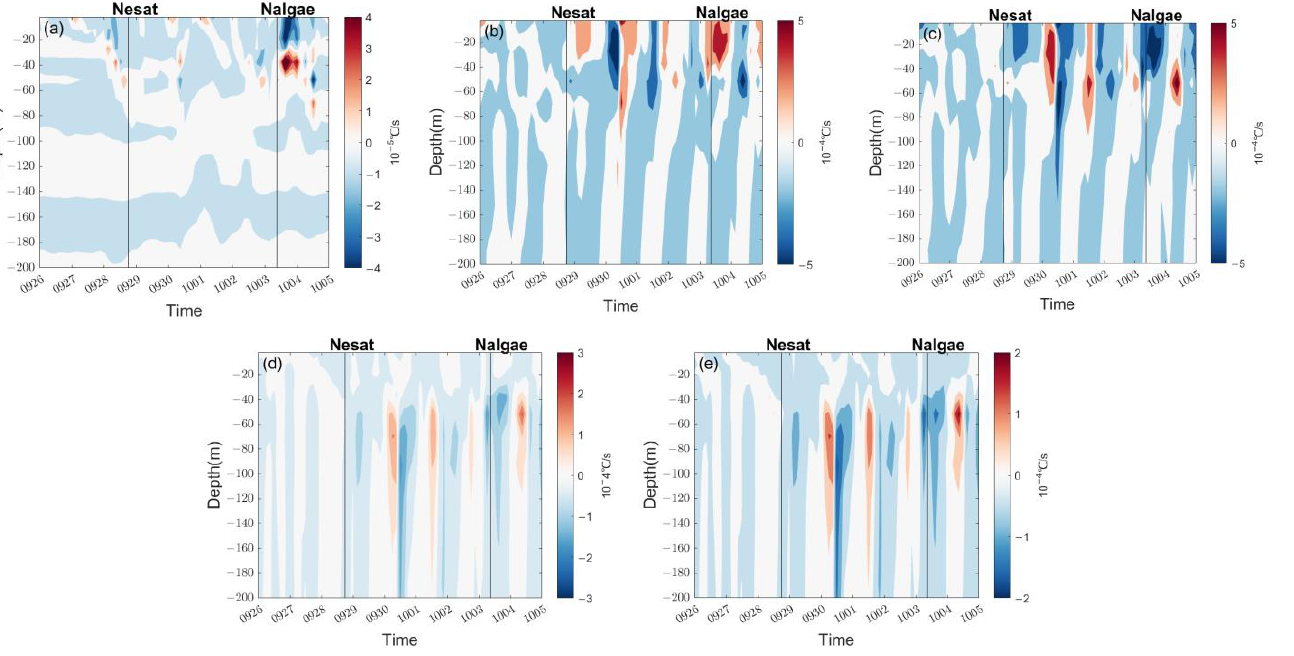
Figure 7. Ocean heat budget term at S2: ( a ) vertical diffusion; ( b ) vertical advection; ( c ) horizontal advection; ( d ) total advection; ( e ) local temperature change rate.